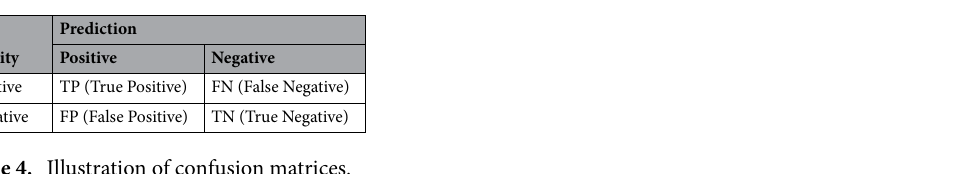
Table 4. Illustration of confusion